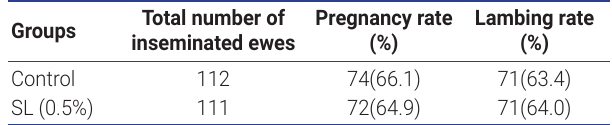
Table 3. Effect of the presence of soybean lecithin in the extender on in vivo results after artificial insemination of semen preserved